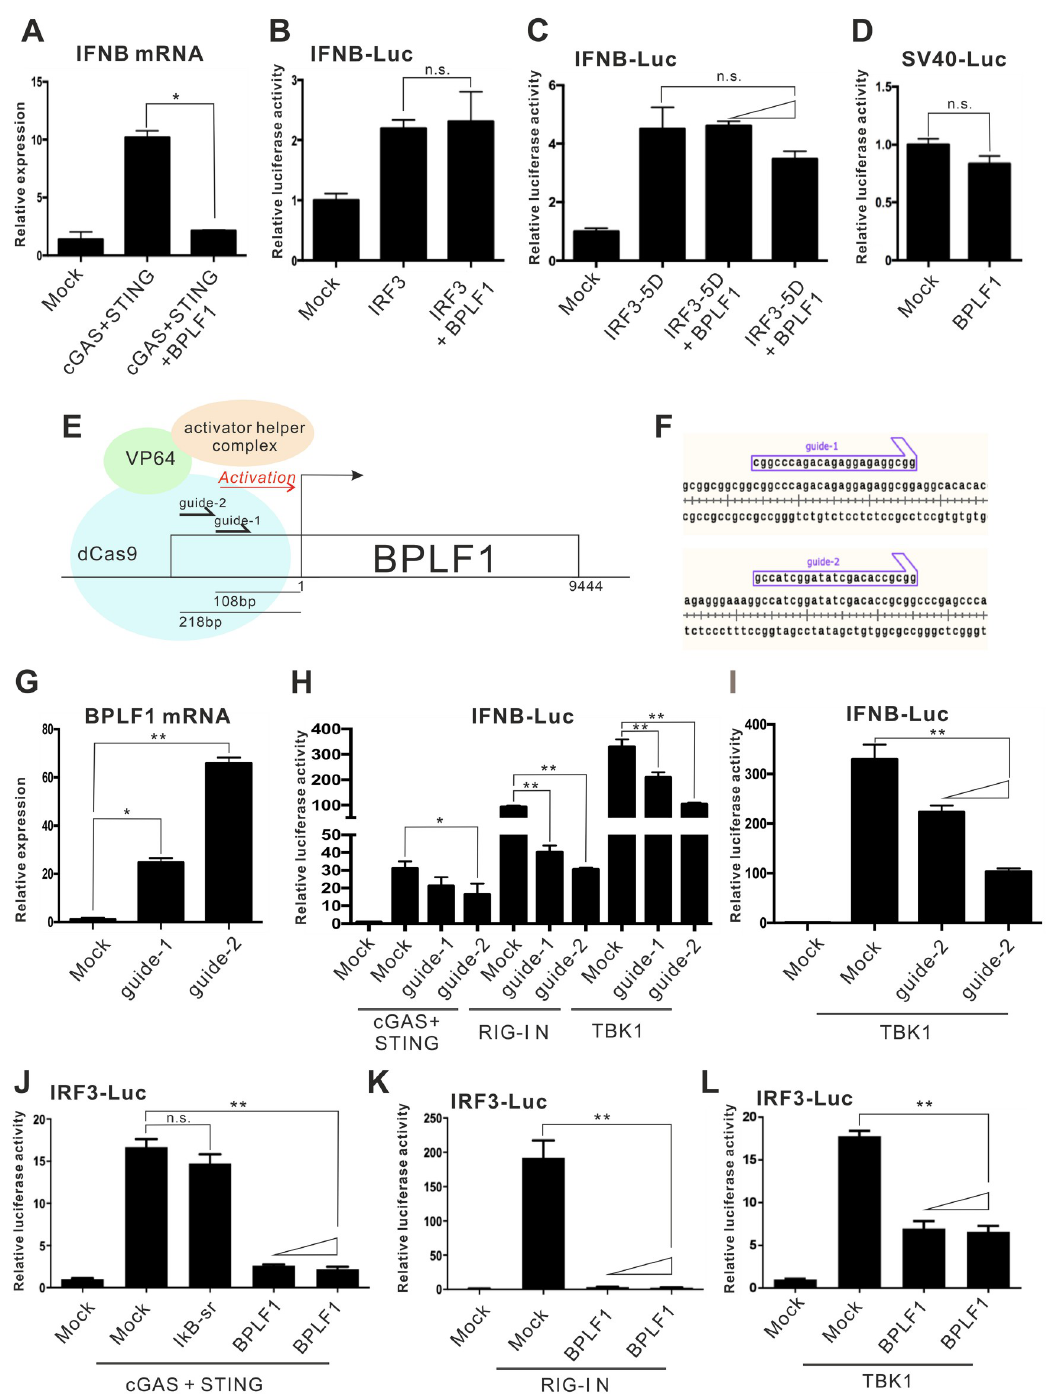
Fig 2. IFN antagonism of BPLF1. (A-D) Specific inhibition of cGAS-STING activity by BPLF1. HEK293 cells were transfected with IFNB-Luc, TK-Luc, either one or two doses of BPLF1 expression plasmid, and expression plasmids for cGAS + STING (A), IRF3 (B) or IRF3-5D (C). Alternatively, a Firefly luciferase reporter driven by the SV40-promoter (SV40-Luc) and TK-Luc promoter were co-transfected with BPLF1 expression plasmid into HEK293 cells (D). Cells were harvested 24 hours post- transfection for dual-luciferase assay. (E) A schematic diagram depicting the targeting regions of the two gRNAs (guide-1 and guide-2) on the EBV genome was presented together with dCas9, four tandem copies of HSV-1 VP16 molecules (VP64) and the activator helper complex. (F) The cDNA sequences of the two gRNAs. (G) Induction of BPLF1 expression by CRISPR-a. HEK293M81 cells were transfected with lentiMPHv2 and lentiSAMv2 carrying guide-1 and guide-2. The total cellular RNA